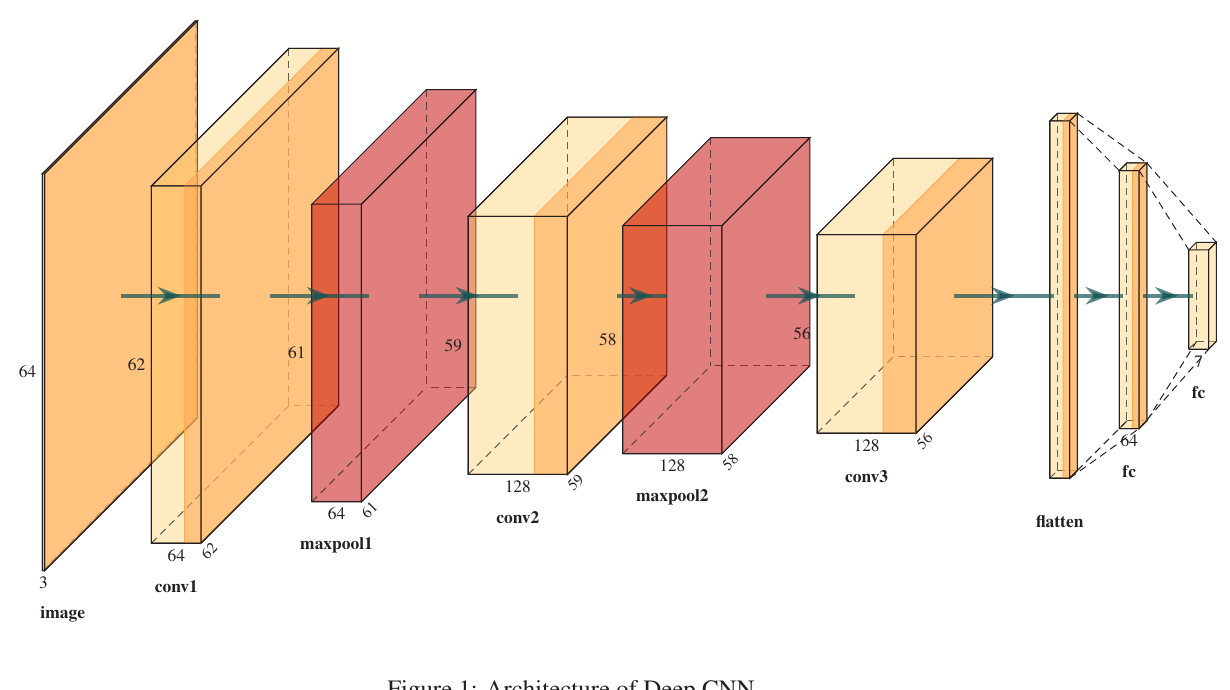
Figure 1: Architecture of Deep